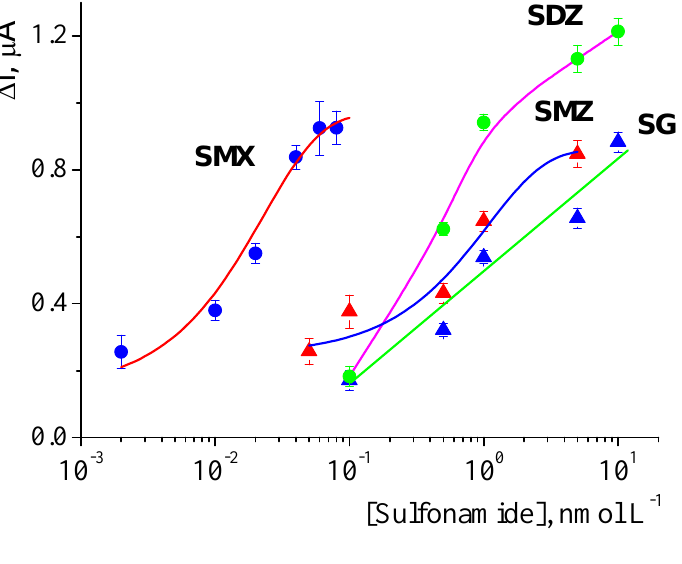
Figure 3. The influence of the sulfonamide concentration on the decay of the DNA-HRP sensor signal. 0.4 µ mol L -1 MB, incubation 10 min. Table 1. Determination of sulfonamide preparations with DNA-HRP